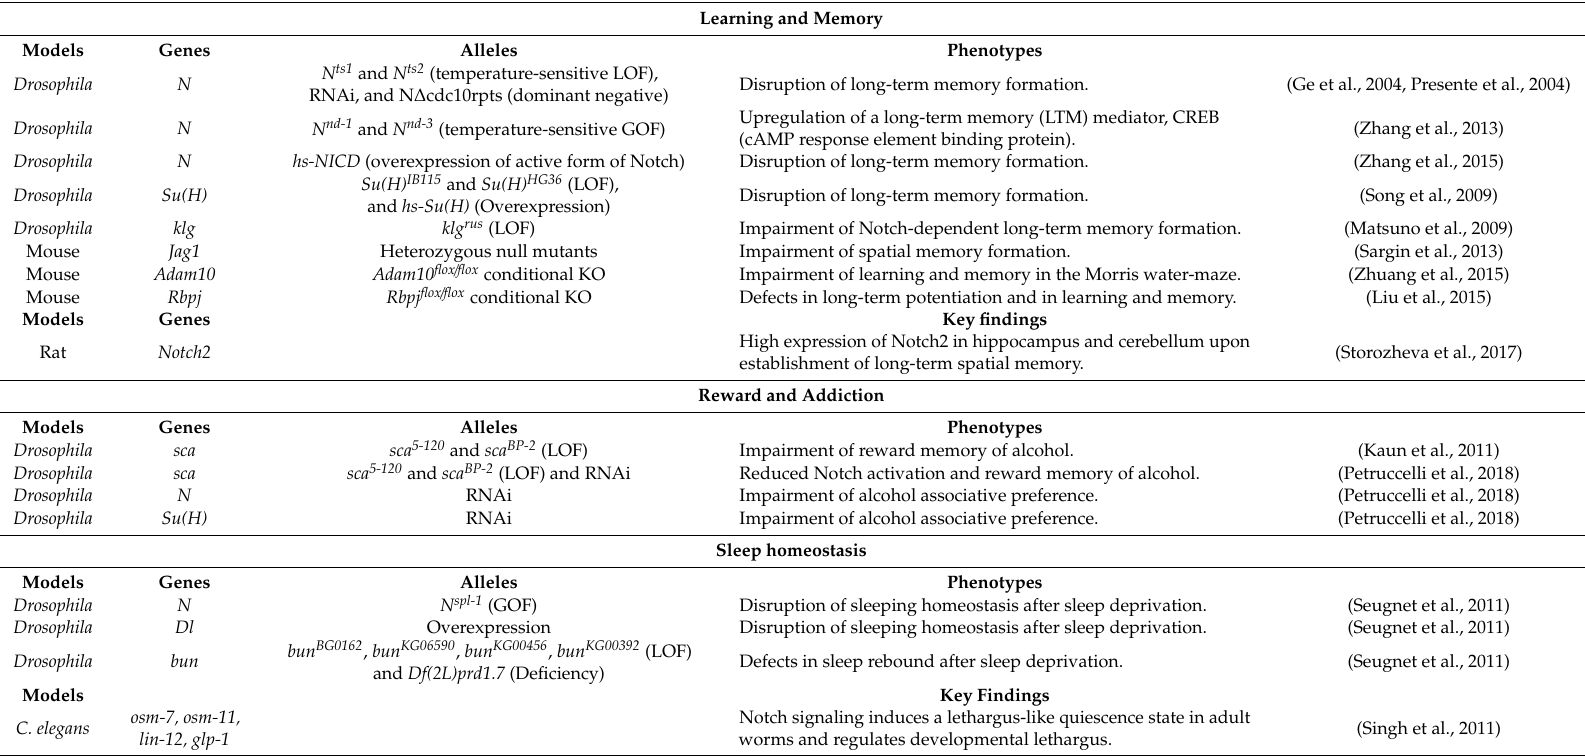
Table 1. Behaviors that are a ff ected by post-developmental Notch